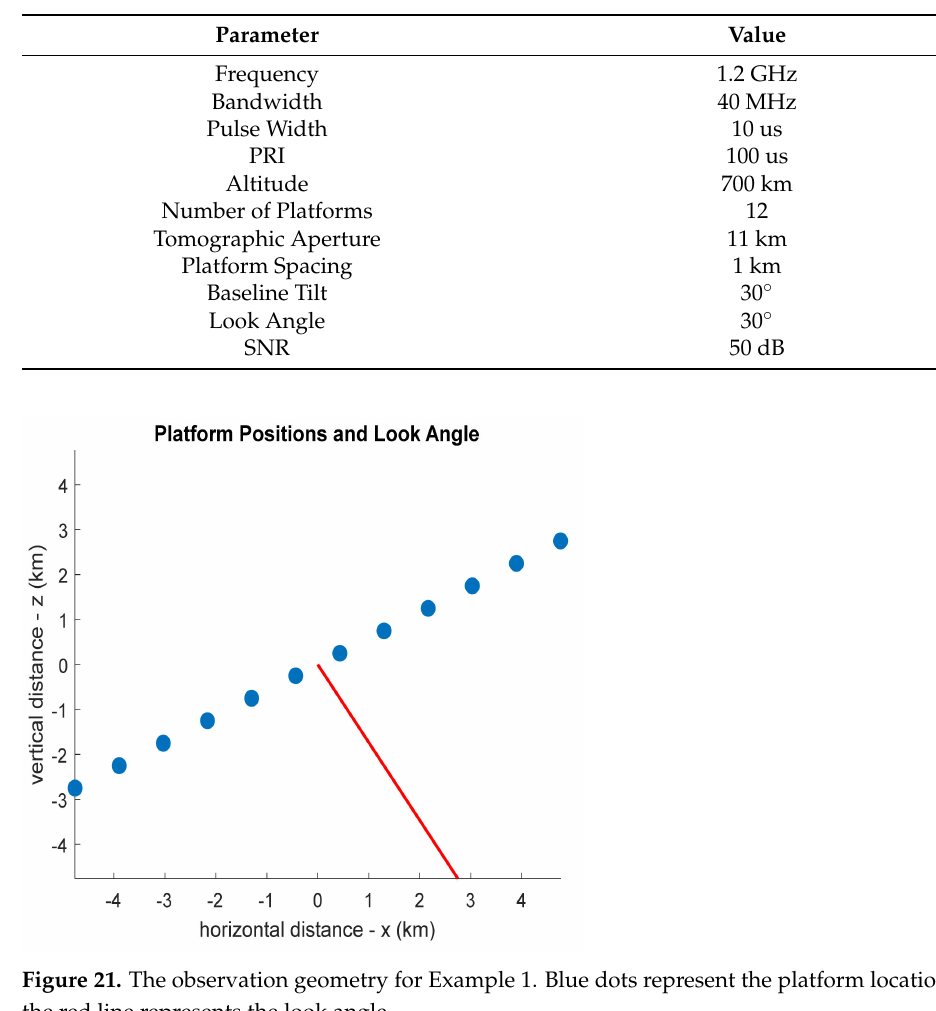
Table 4. Parameters used for Example 1.